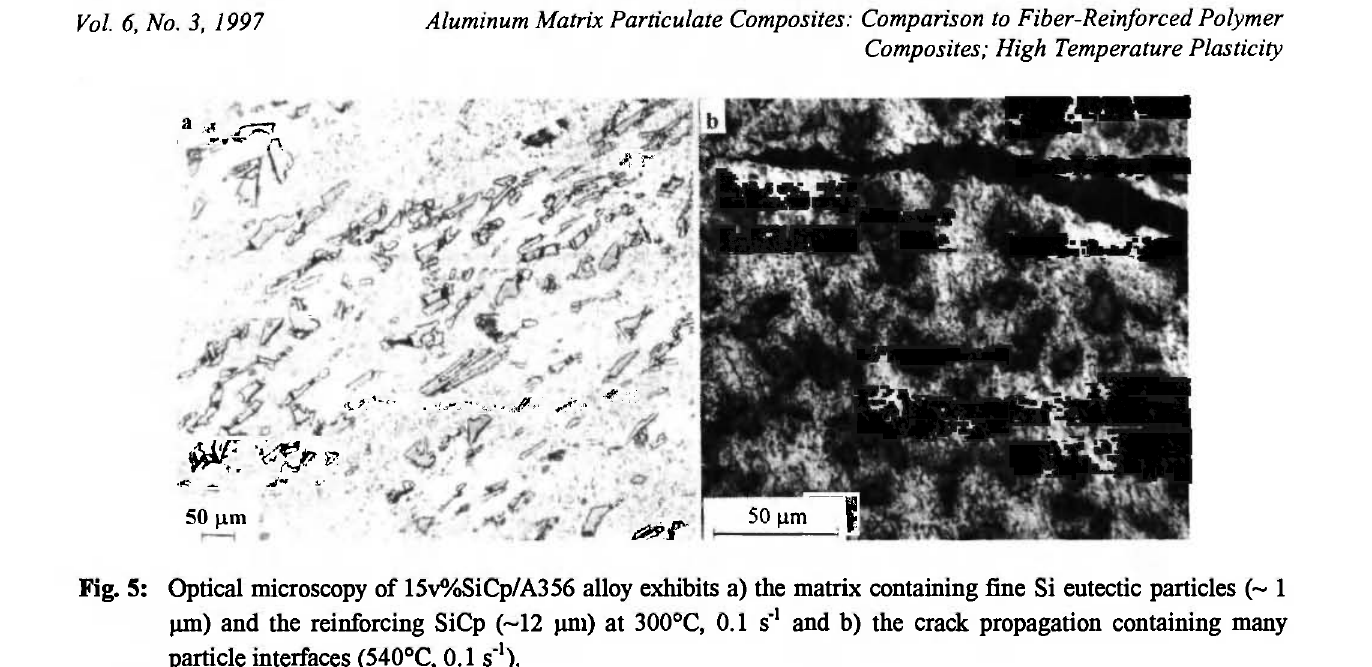
Fig. 5: Optical microscopy of 15v%SiCp/A356 alloy exhibits a) the matrix containing fine Si eutectic particles (~ 1 μηι) and the reinforcing SiCp (-12 μηι) at 300°C, 0.1 s" 1 and b) the crack propagation containing many particle interfaces (540°C, 0.1 s" 1